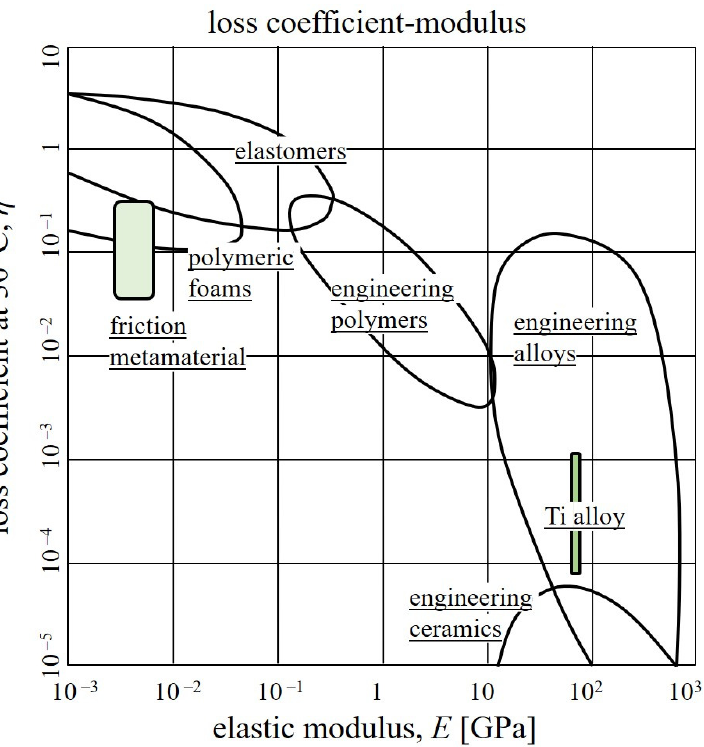
Figure 6. Loss coefficient–elastic modulus diagram of different materials according to Ashby [5] and the developed metamaterial. the developed